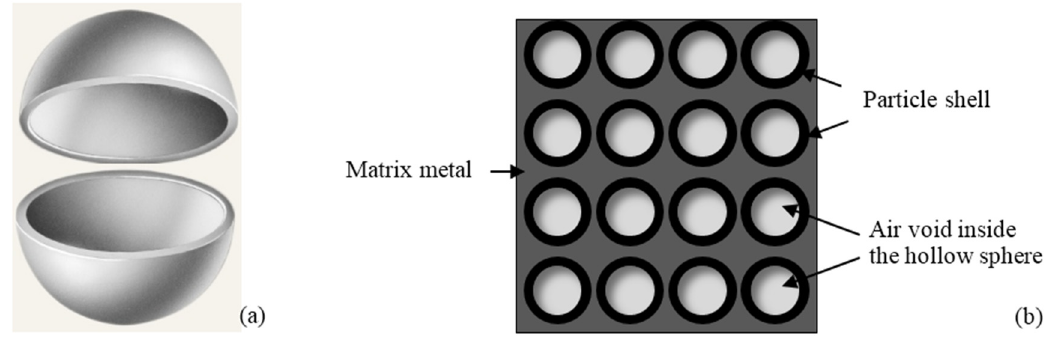
Figure 5. Scheme of a hollow particle ( a ); and its distribution on metal matrix of a syntactic foam ( b ).